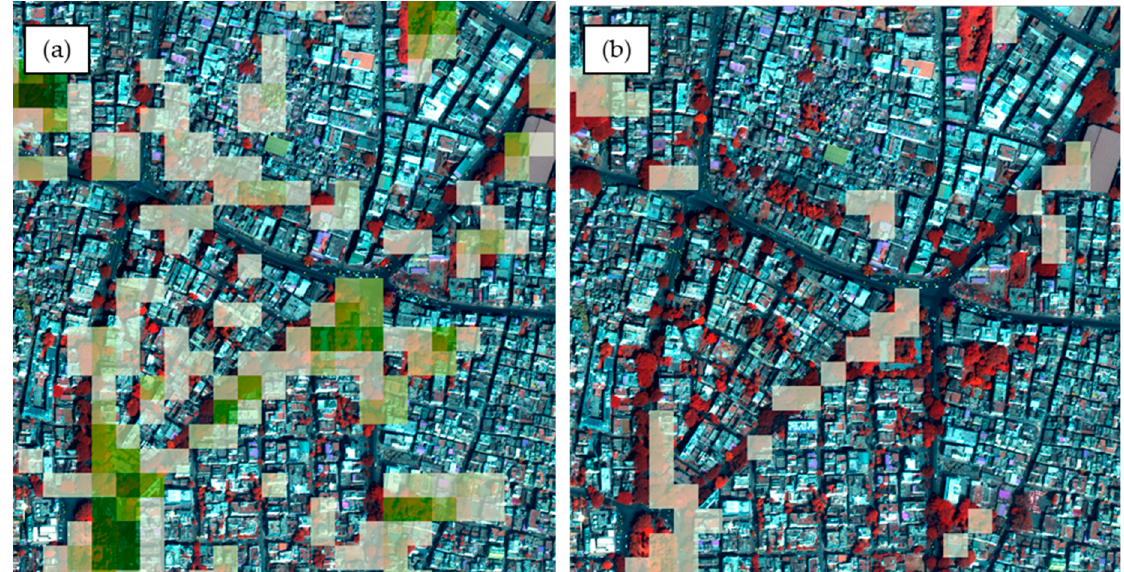
Figure 5. 600 m × 600 m subset of the WorldView-3 image from the urban parts of our study area, with alleys and solitary trees of varying crown size overlaid with ( a ) our predicted Landsat tree cover per pixel and ( b ) the Global 30 m Landsat Tree Canopy Version 4. The bright green pixels in ( b ) show a very low canopy cover, which obviously should be much higher when looking at the WorldView-3 image. Our prediction ( a ) shows a more reasonable canopy cover.